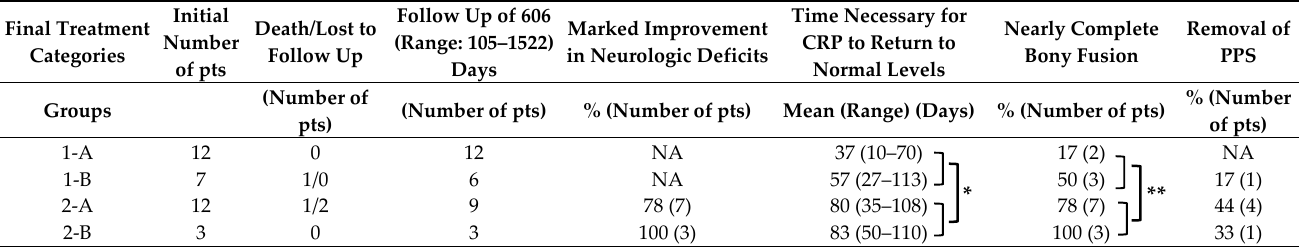
Table 2. Evaluation of outcome.